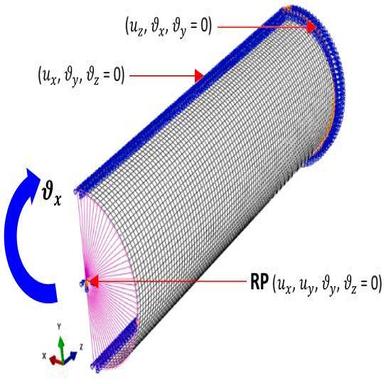
Pipe model geometry showing FE discretization.